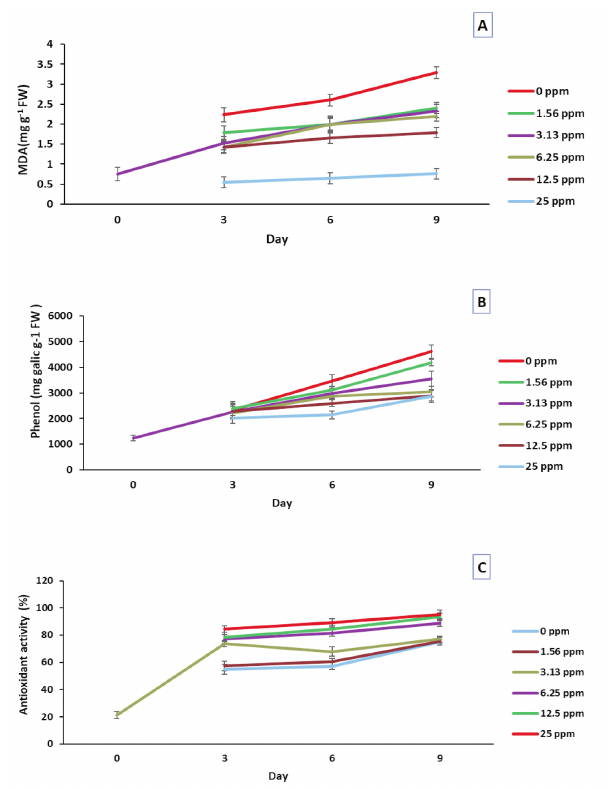
Fig. 2 ­ The influence of cumin EO concentrations on the MDA (A), phenol content (B), and antioxidant activity (C) under different observation periods in cold­stored